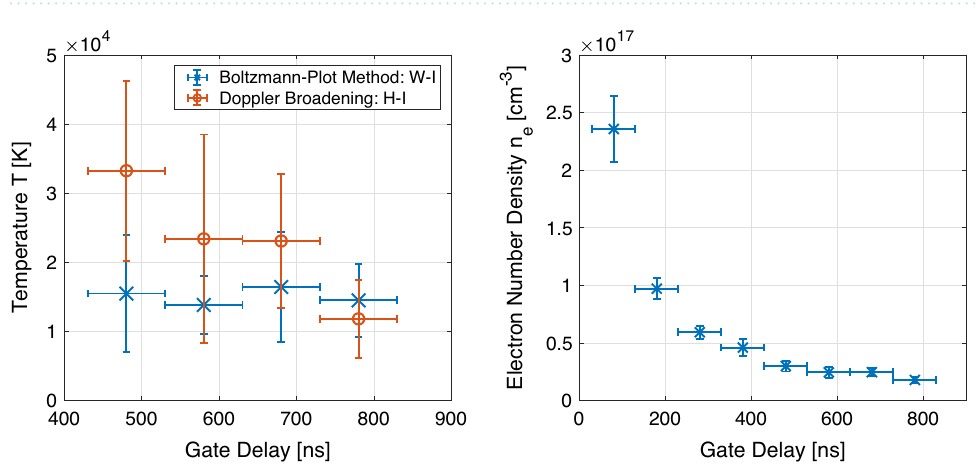
Figure 3. Left: Plasma temperature T evaluated from the observed tungsten (W) spectrum by using the Bolzmann-plot method including atomic W-I lines in blue crosses and the Doppler Broadening of the H α line in orange circles. Right: Electron number density n e evaluated by Stark broadening of the same line. Error-bars indicate statistical deviations from the measured values on the y-axis and the used gate width on the